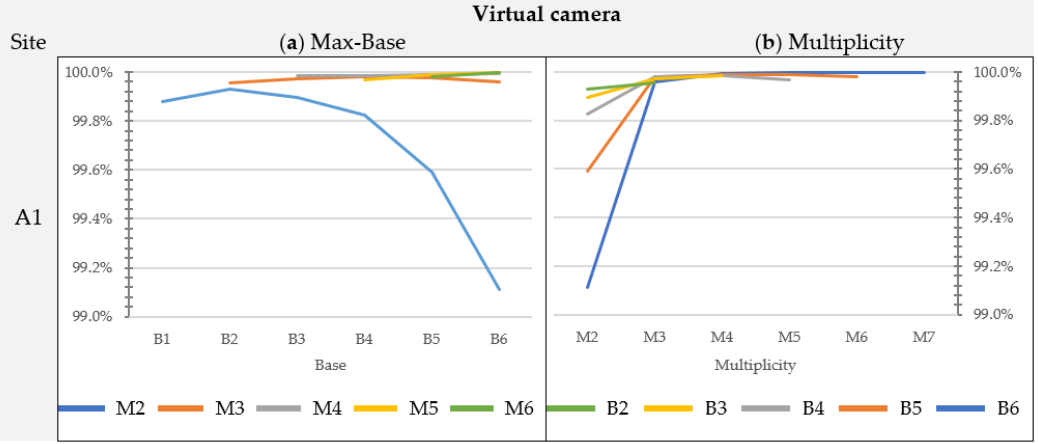
Figure 12. Graphs showing the DEM completeness in percent for Site A1: ( a ) influence of max-base variability and ( b ) the influence of multiplicity.